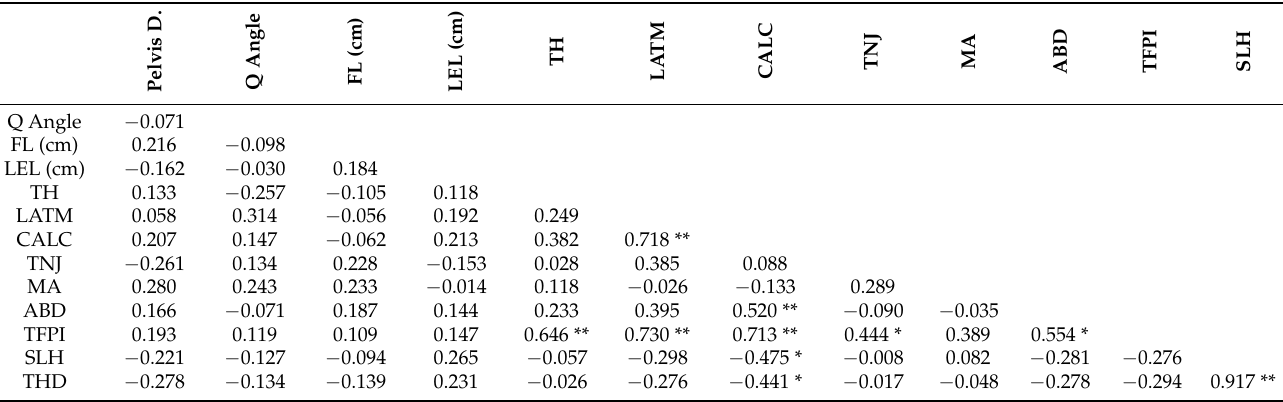
Figure 3. Comparison of TFPI scores of operated and non-operated sides. * p < 0.05. When the correlations between pelvis diameter, Q angle, FPI, lower extremity length, and SLHT on the operated side were examined, positive correlations were found between TFAPI and ABD (r = 0.554), TFFPI and TNJ (r = 0.444), ABD and CALC (r = 0.520), TFAPI and TH (r = 0.646), TFAPI and LATM (r = 0.730), TFAPI and CALC (r = 0.713), and THD and SLH (r = 0.917). Negative and significant correlations were found between SLH and CALC (r = − 0.475) and THD and CALC (r = − 0.441) (Table 5). Table 5. Correlation between pelvis diameter, Q angle, foot posture index, lower extremity length, and single hop test on the operated side.